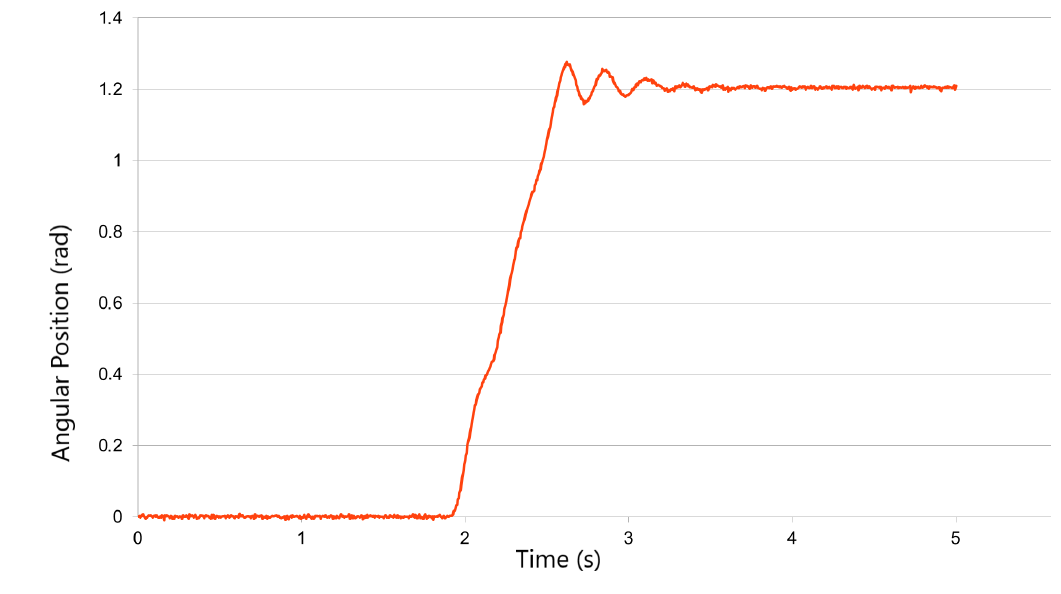
Figure 16. Position Controller, Step Reference.